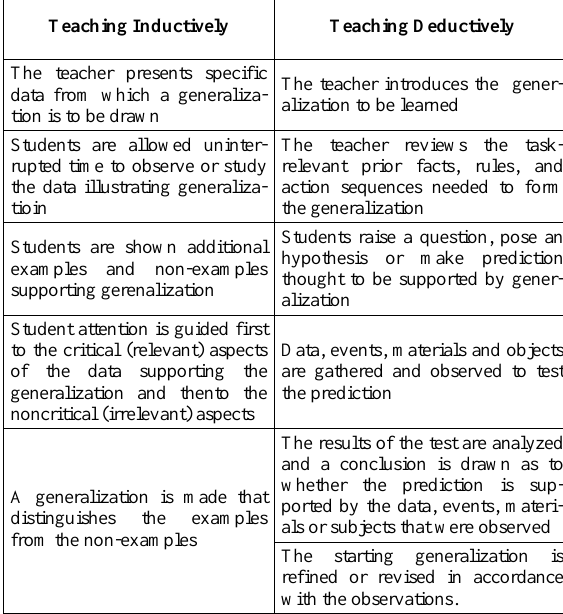
TABLE II. C OMPARISON OF I NDUCTIVE AND D EDUCTIVE T